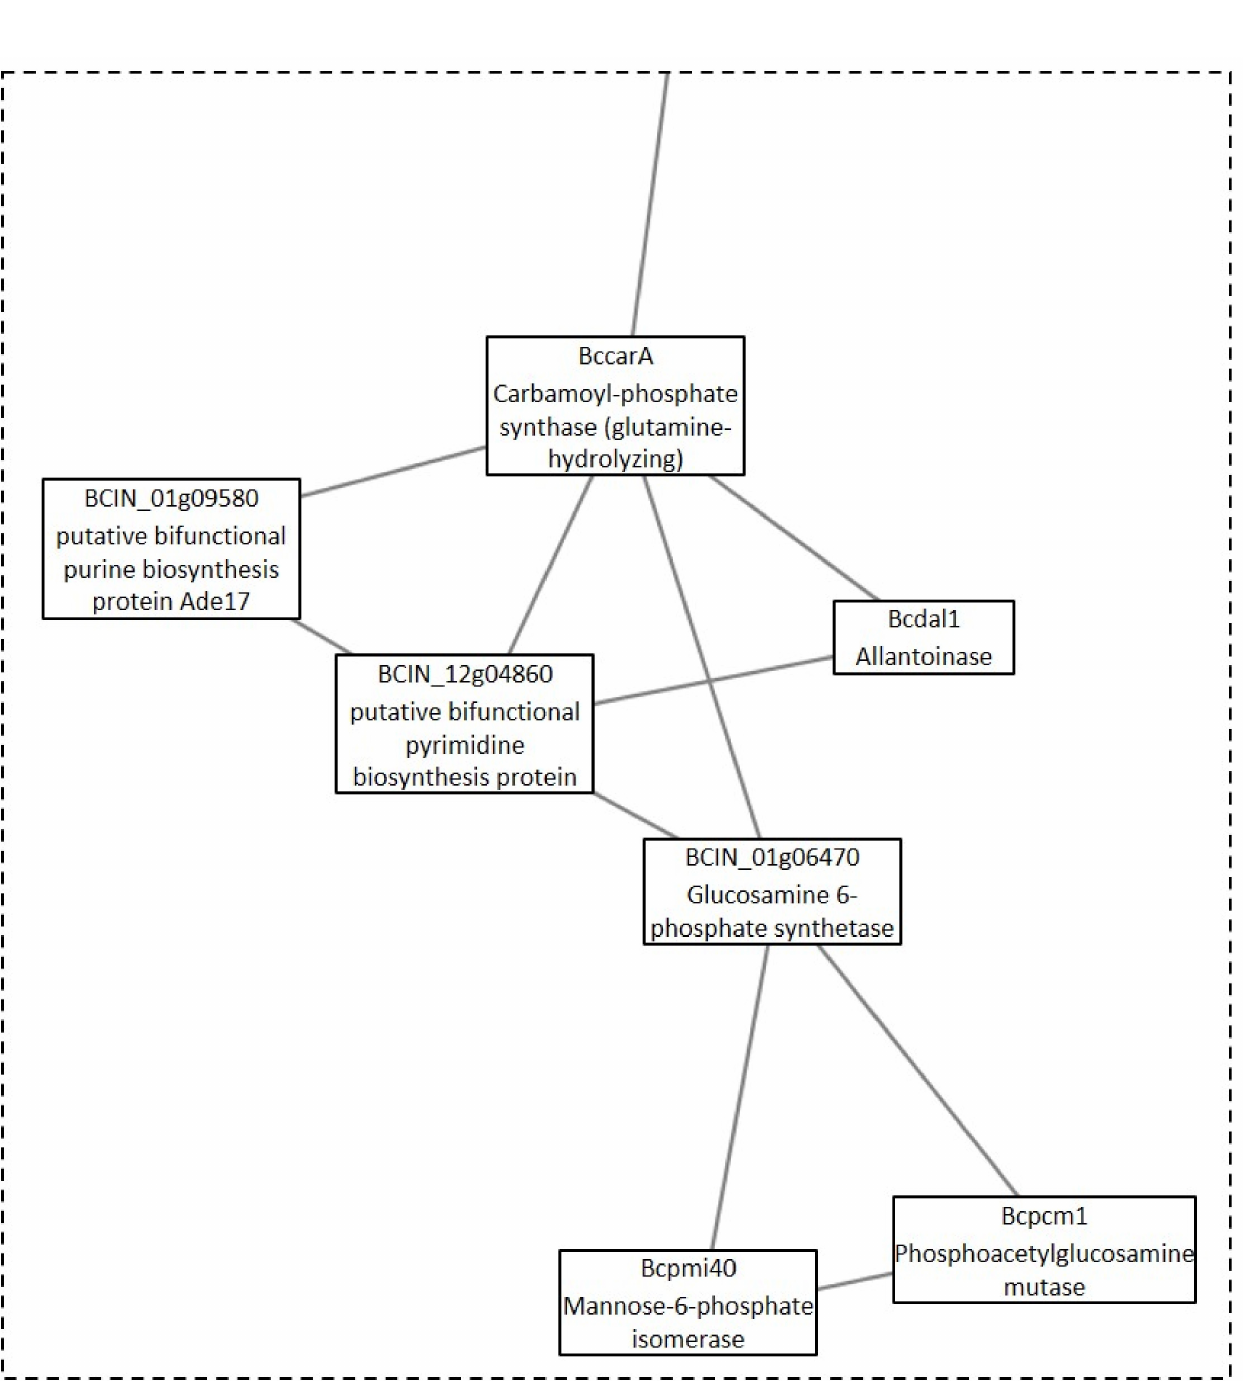
Figure 10. Section C from Cluster 10 (Figure